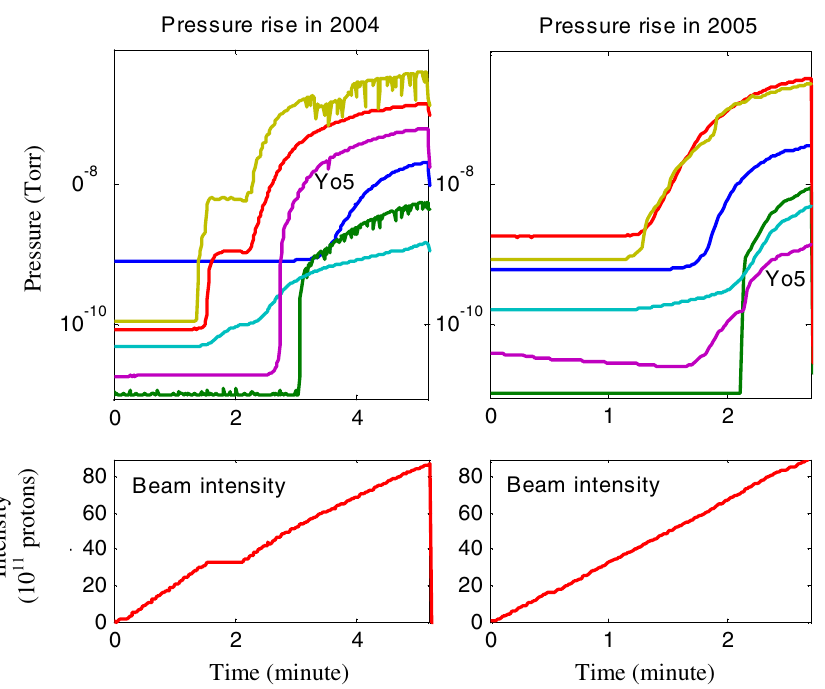
FIG. 6. (Color) The pressure rise at 6 single beam straight sections is shown for yellow beams in the 110-bunch mode and bunch intensity of 1 : 5 (cid:3) 10 11 protons in 2004 and 2005. The purple line is for the Yo5 pressure rise, which is reduced by more than a factor of 50 in 2005 with the ridges, compared with that in 2004 without ridges. The pressure rise at the 5 straight sections without change in chamber conditions, i.e., Yi3, Yi7, Yo9, Yi11, and Yo12, is not much changed from 2004 to 2005.